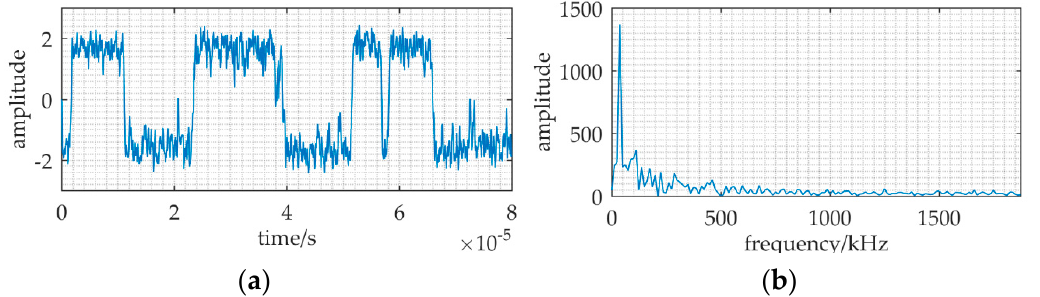
Figure 12. The result of RFSR applied to the ULB signal detection when the sampling frequency is f s = 18.75 MHz. The sampling data length is still N = 1500 and the other parameters are the same as Figure 11.